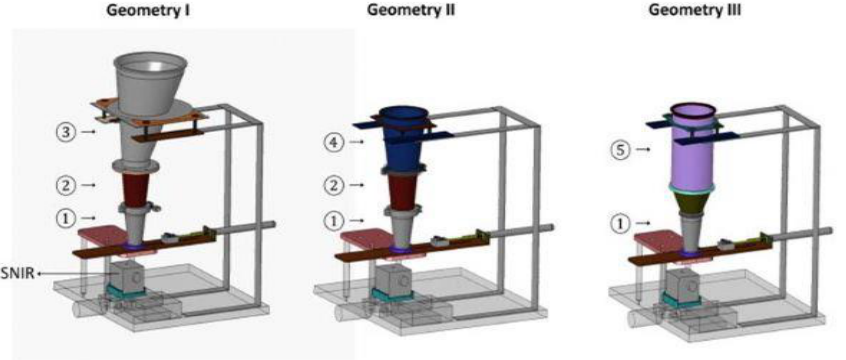
Figure 5. Possible hopper geometries: I — asymmetrical conical; II — symmetrical conical; III — cylindro-conical, as studied by Abatzoglou et al., adapted with permission from [52]; published by Elsevier, 2014.